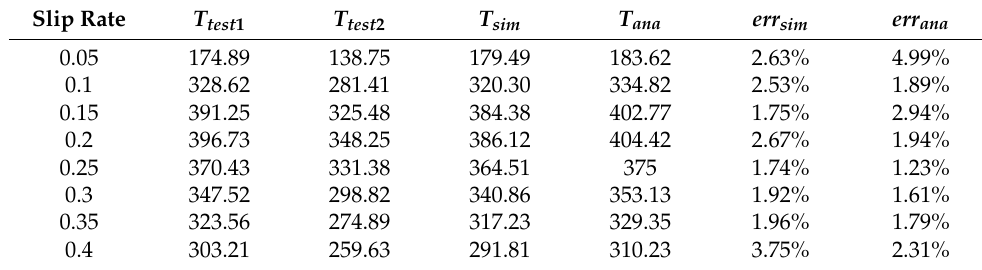
Table 4. Comparison of output torque under different speed